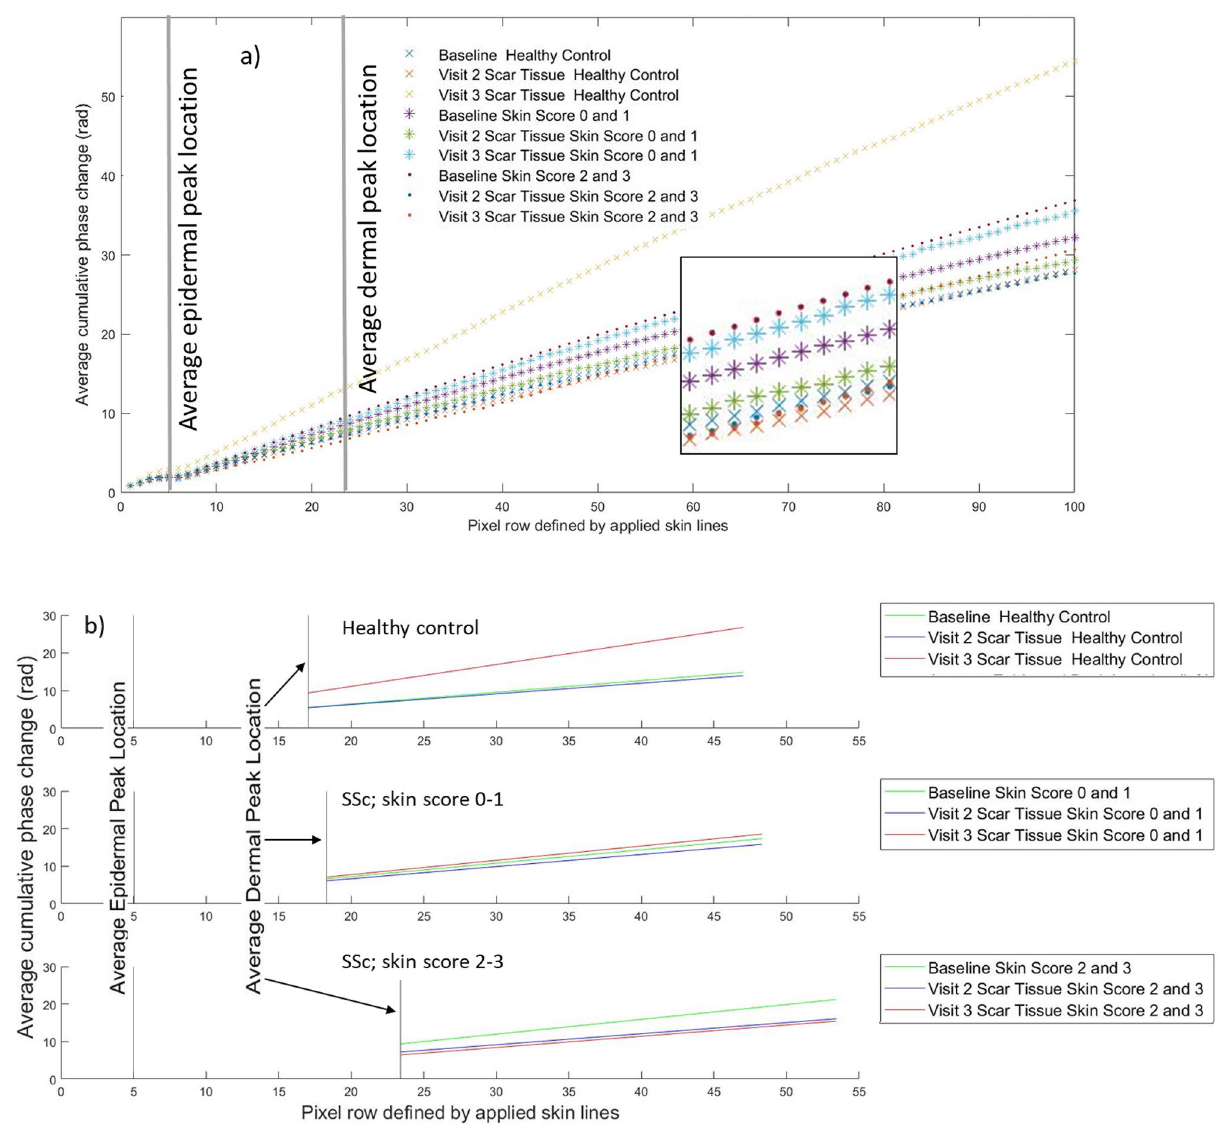
Figure 5. ( a ) Cumulative retardance plotted with depth for the three visits grouped for HCs and patients with skin scores 0–1 and 2–3 (without error bars for clarity, a version with error bars is shown in the Supplementary data). Averaged locations for the epidermal and dermal peaks over all groups are denoted by the vertical grey lines. Inset box is a higher magnification of the lines to enable clearer view of the trends. Baseline data shows the same trend as for Fig. 4. The graph indicates that for both HCs and patients with skin scores of 0–1 (mild fibrosis) retardance decreases from baseline to one-week post biopsy visits but then increases by the one-month visit to above the baseline retardance value, with the HC one-month retardance being higher than SSc values. In contrast the patients with skin score 2–3 (moderate to severe) whilst also showing a show a decrease at the one- week visit show an increase at one-month that is still below the baseline retardance value. Baseline N = 10 for both HC and SSc, one-week visit, N = 8 for HCs and N = 7 patients, one-month N = 5 for HCs and N = 4 for SSc; ( b ) gradients of the data in ( a ) displayed grouped across the baseline, 1-week and 1-month visits for each group separately; average dermal peak is shown per group. Each gradient beginning at the individual group average for dermal peak